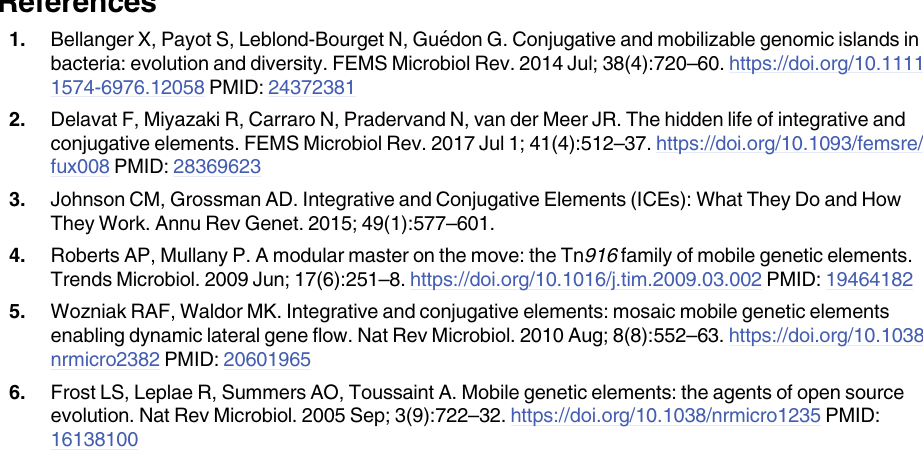
S1 Table. Mapping ICE integration sites in transconjugants. This table includes information about the location and stability of different ICEs in transconjugants after transfer from specific donors. Elements and respective donors include: Tn 916 (ELC1566), ICE Bs1 - tetM